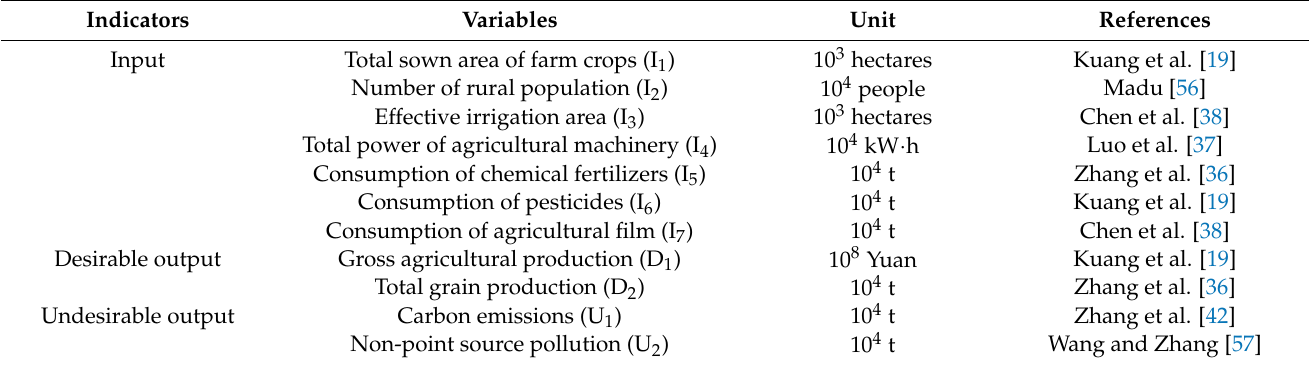
Table 2. Measurement indexes of